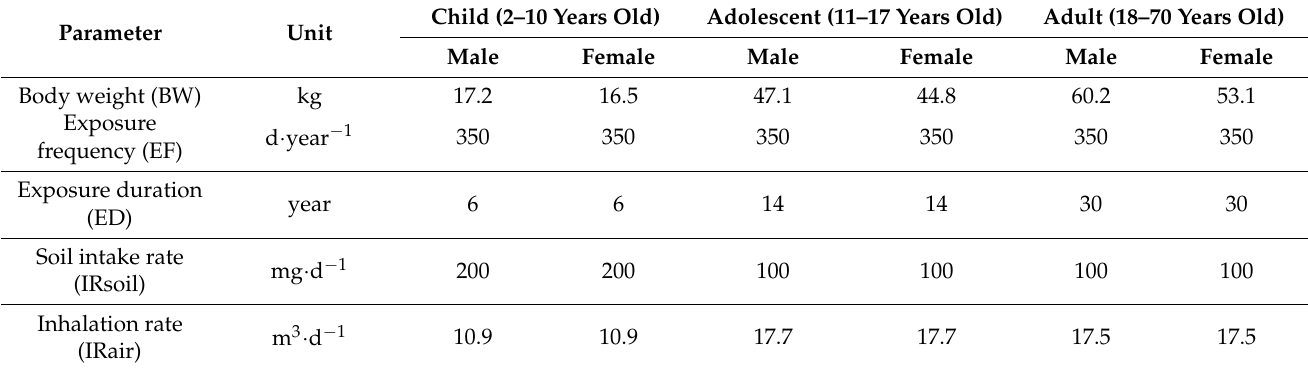
Table 2. Parameters used in the ILCR calculation